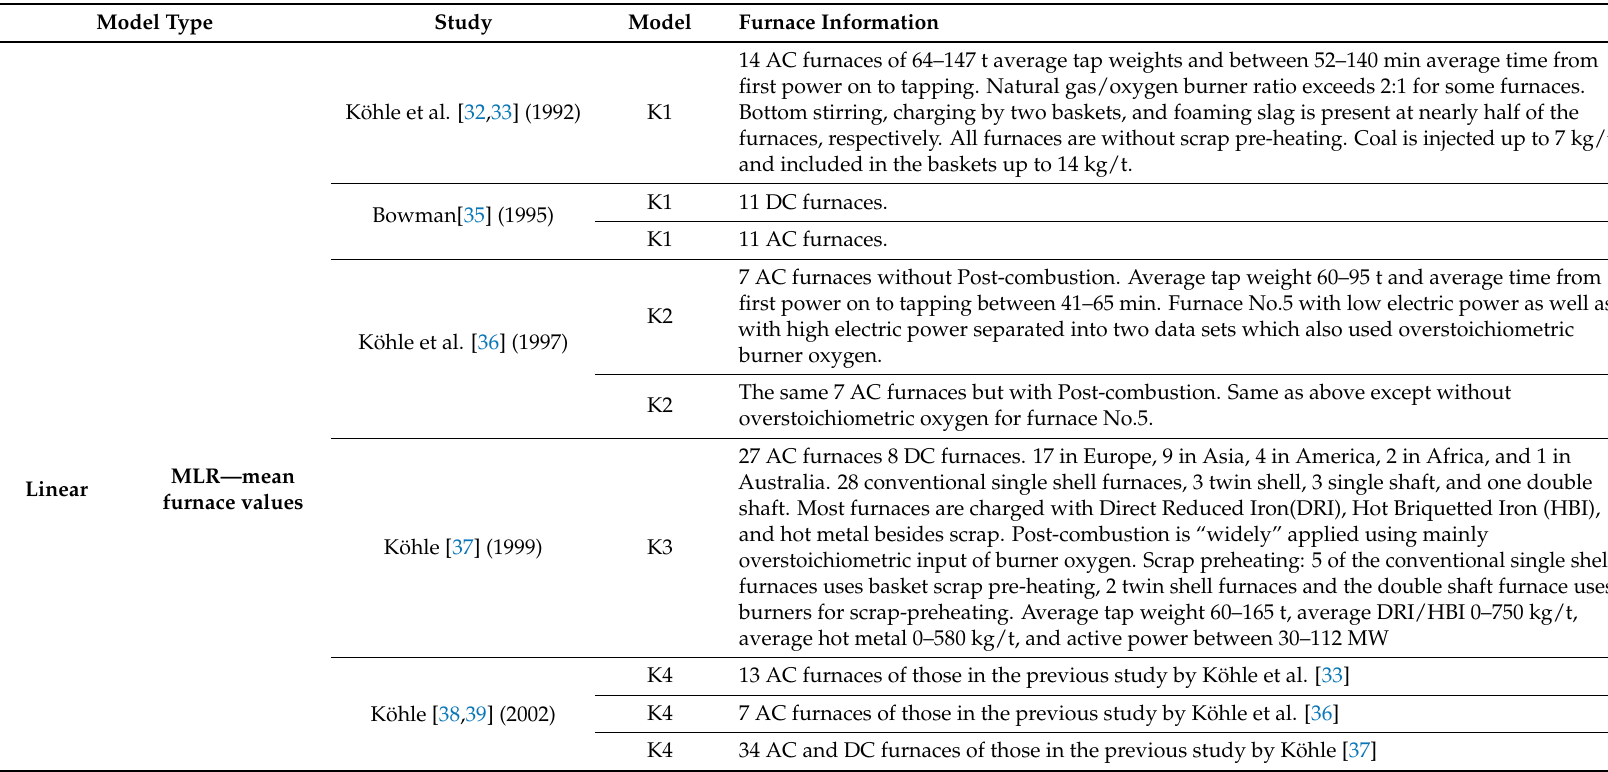
Table 8. Furnace information for all model results as shown in Table 6. Each label represents a new model or heats tested on another